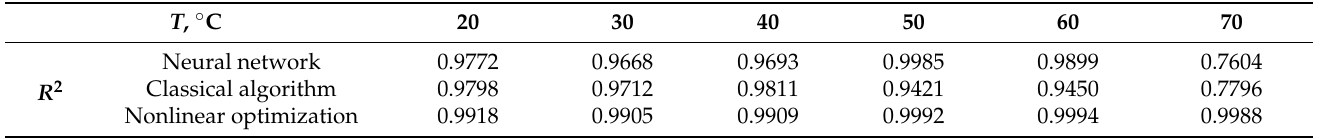
Table 3. Comparison of R 2 determination coefficients using three methods for determining the rheological